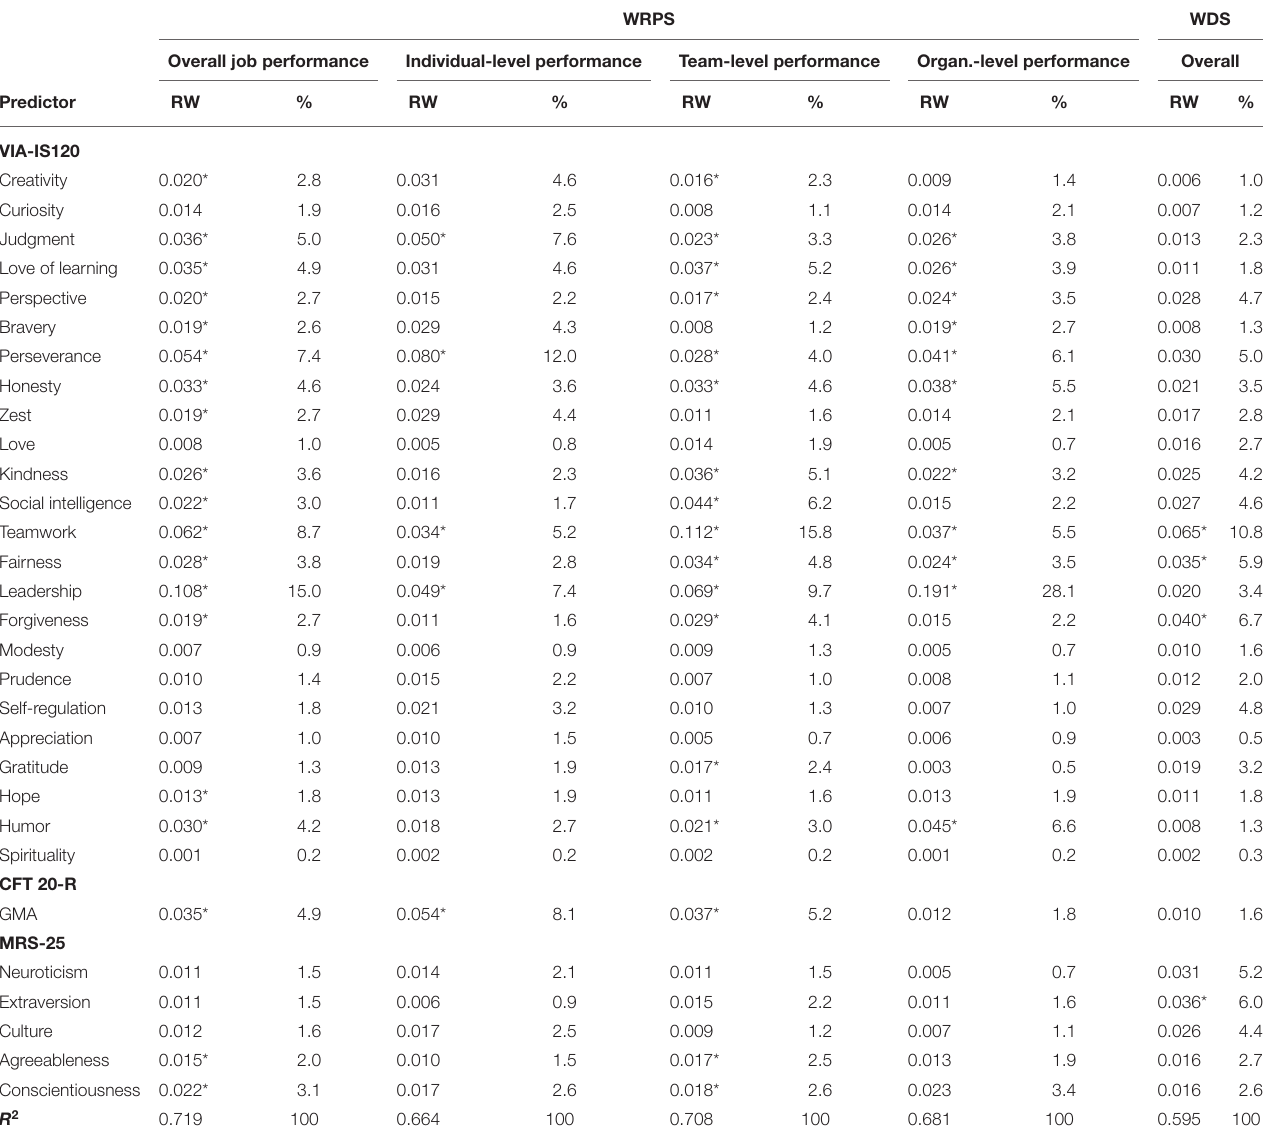
TABLE 8 | Relative weights (RW) and percentages of explained criterion variance (%) for all character strengths, GMA, and the Big Five (VIA-IS120 scales, CFT 20-R, and MRS-25 scales) for overall job performance, individual-level performance, team-level performance, and organization-level performance (WRPS scales) as well as overall deviant behavior at work